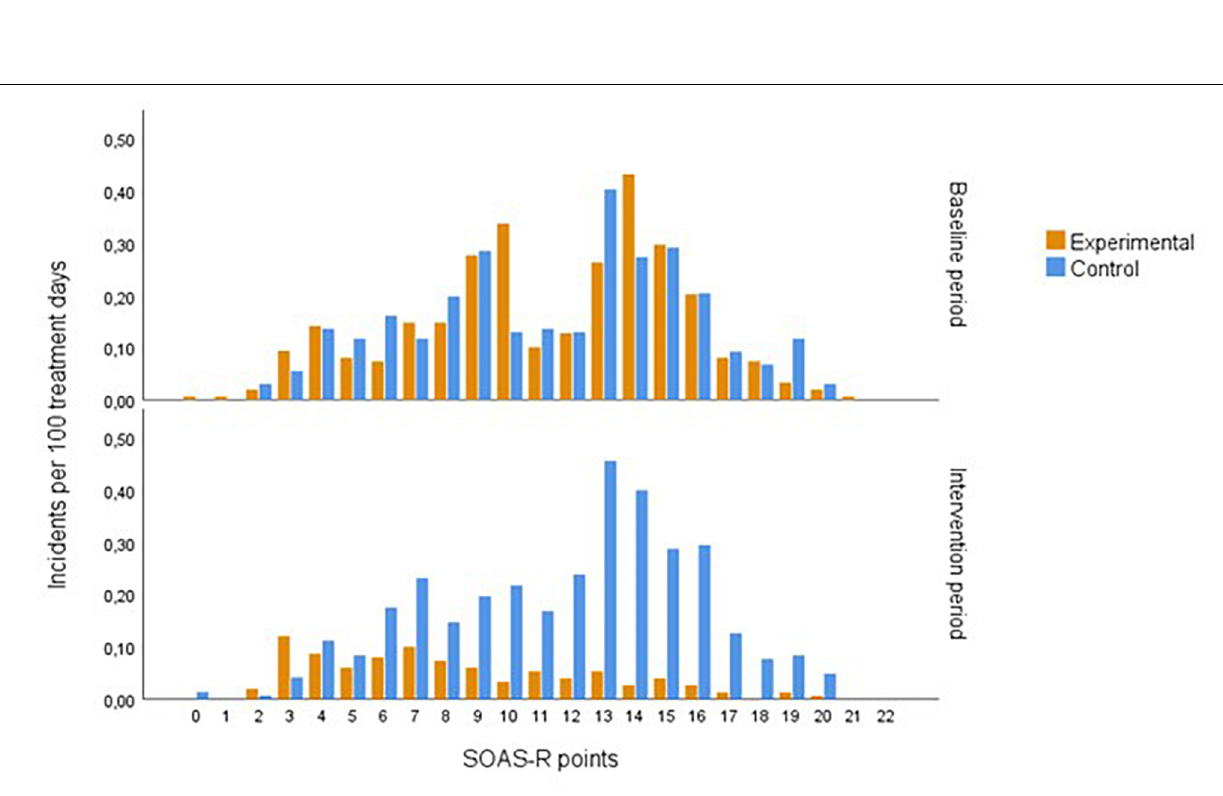
FIGURE 4 | The frequency distribution of the severity of aggressive incidents during study